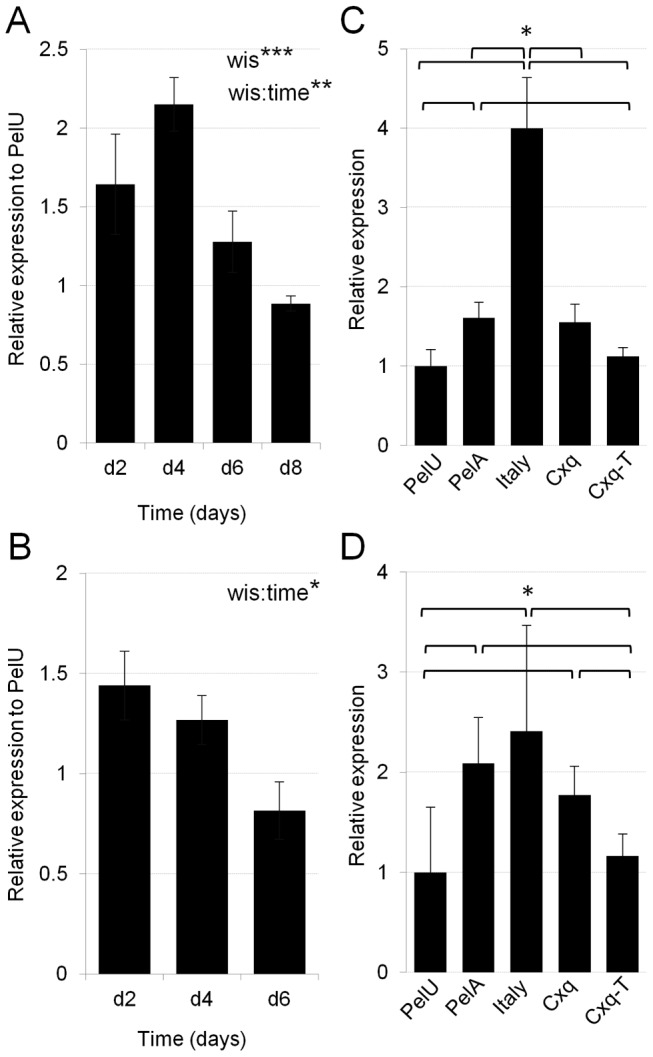
Transcription analysis of CPIJ005623 in the Culex pipiens complex.
A–B. CPIJ005623 transcription in adult female (A) and male (B) Culex quinquefasciatus, Pel (Wolbachia-infected) line relative to the Wolbachia-uninfected PelU, over time (days post pupal eclosion). Similar decreasing expression dynamics was seen in both sexes. C–D. Tissue analysis of CPIJ005623 transcription at 4 d in ovaries (C) and 1 d in testes (D) in C. quinquefasciatus Wolbachia-infected lines Pel and Cxq (30), their Wolbachia-free counterparts PelU and CxqT, and Wolbachia-infected Italy line C. molestus. Upregulation of CPIJ005623 expression is seen in all Wolbachia-infected lines. Average of the mean values of four biological repeats (+/− standard error-SE) are presented. Two-way ANOVA statistical analysis was used to determine effect of Wolbachia infection status (wis) and time on CPIJ005623 expression. Wilcoxon rank-sum test was used to determine differences between Wolbachia infection status in CPIJ005623 expression (C–D): *p<0.05, **p<0.01, ***p<0.001.